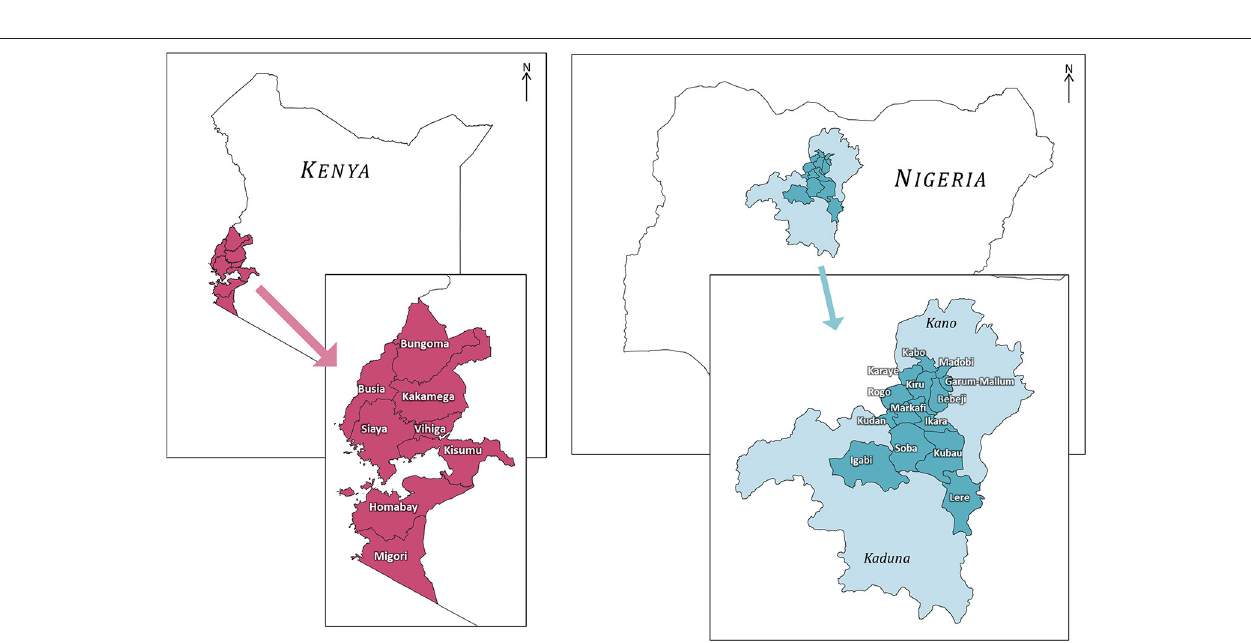
FIGURE 2 | The locations of the counties in Kenya and LGAs in Nigeria in which surveys were undertaken. Different map images are not to